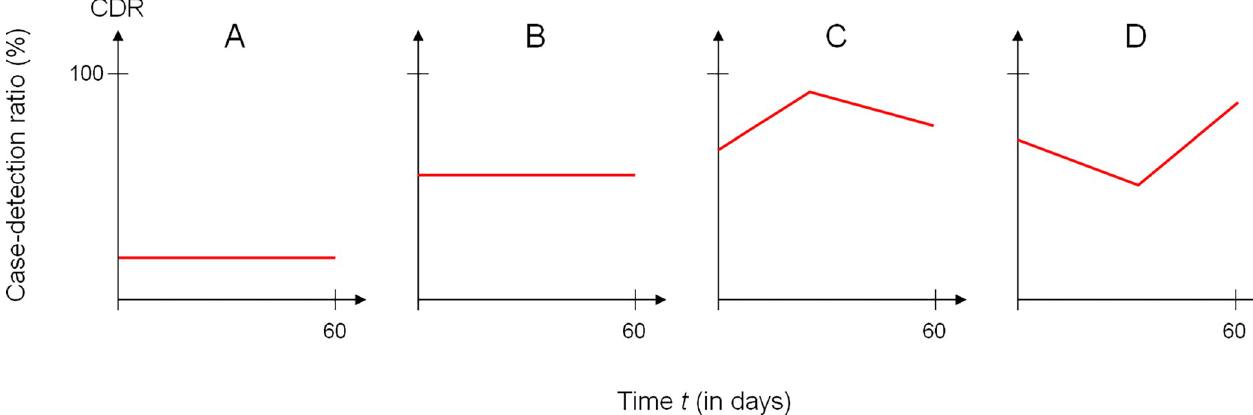
Fig 3. Simulated case-detection ratios (CDRs). CDRs during the pandemic in the four simulated scenarios A to D.